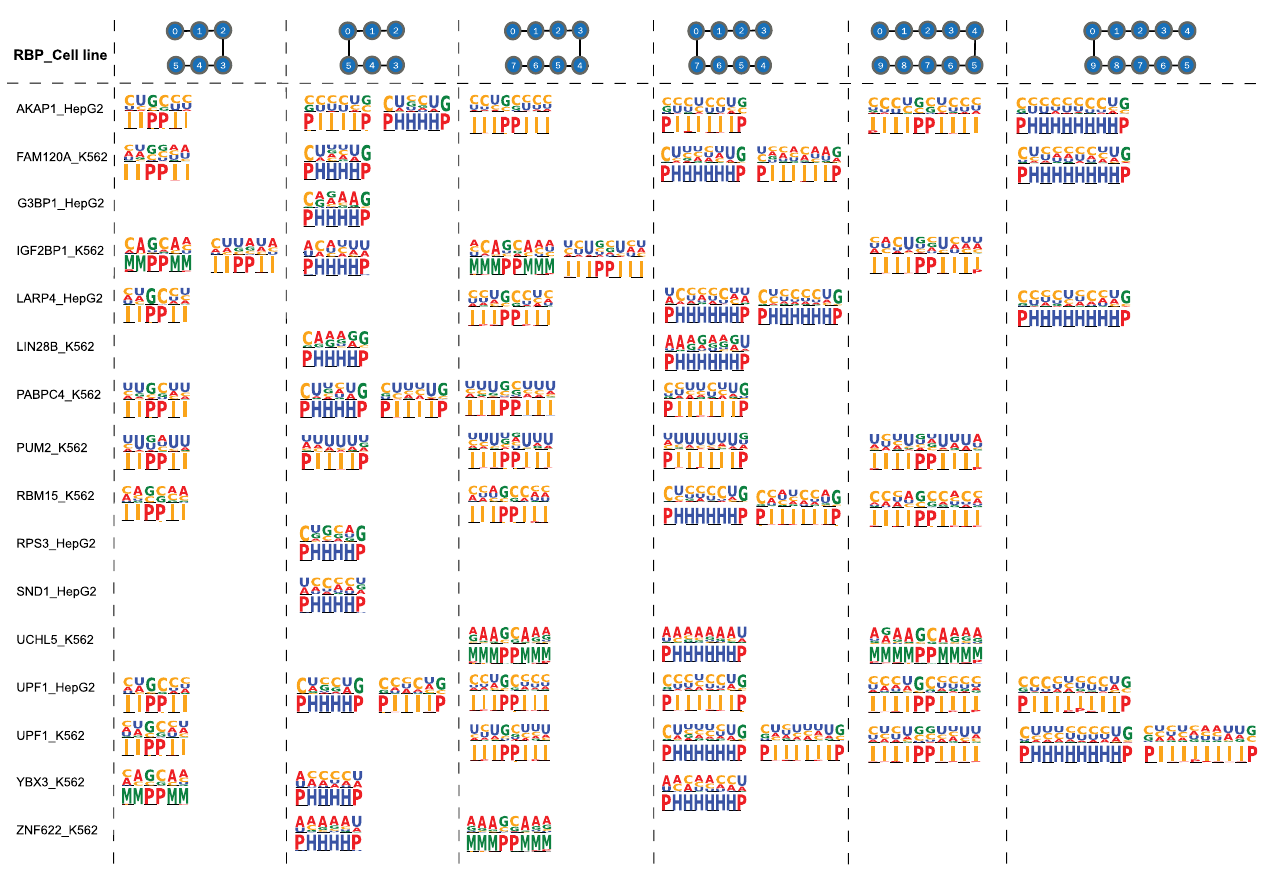
Fig 5. Combined sequence and structure logos of significant modules of 16 RBPs. Left-opened and right-opened EKSes of different sizes are displayed.